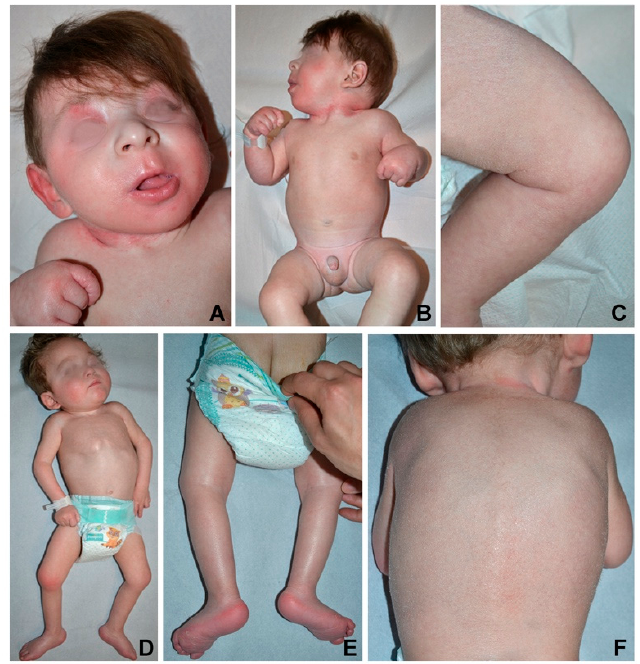
Figure 1. Clinical features: mild facial dysmorphism and erythema ( A ), proximal and distal limb hypertonia and neck erythema ( B ), slight thigh hyperkeratosis with fine whitish desquamation ( C ) in patient 1 at 7 months of age. Similar skin findings ( D – F ) and plantar keratoderma with erythema ( F ) are visible in patient 2 at 19 months of age. In the latter case, note also pectum carenatum and the dystonic posturing of the trunk, proximal limb hypotonia with frog-leg positioning and distal limb hypertonia with clenched fists ( D ).